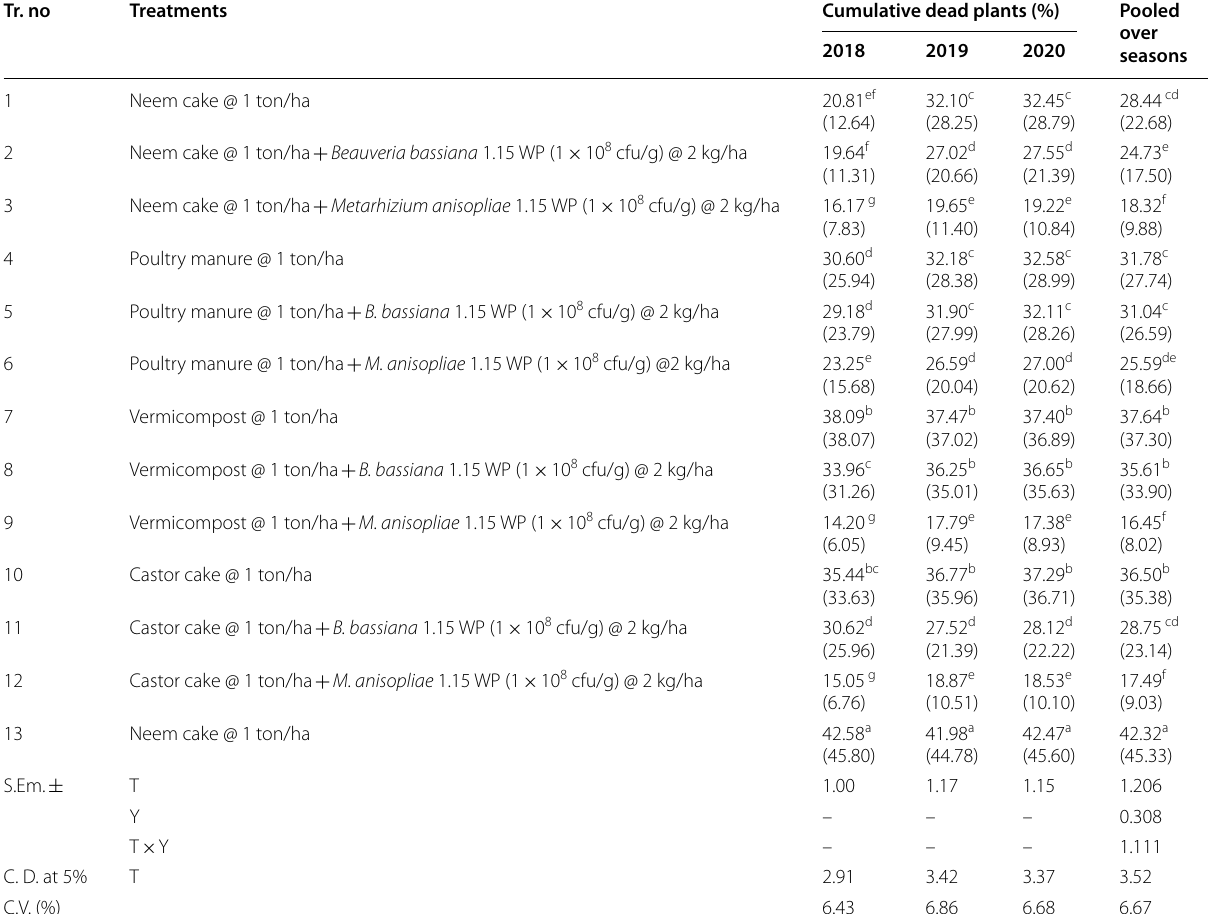
Table 6 Effect of entomopathogenic fungi enriched with organic amendments against white grub in groundnut (pooled over